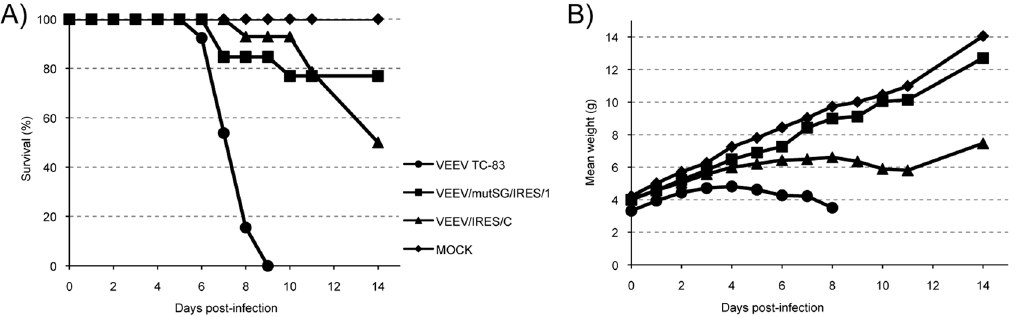
Figure 6. Virulence in mice after injection of VEEV TC-83 and IRES-based viruses. Six-day-old CD1 mice received 5 6 10 4 PFU of indicated viruses SC, and were monitored 2 weeks for survival (A) and weight change (B). No deaths were recorded after day 14 post-infection.